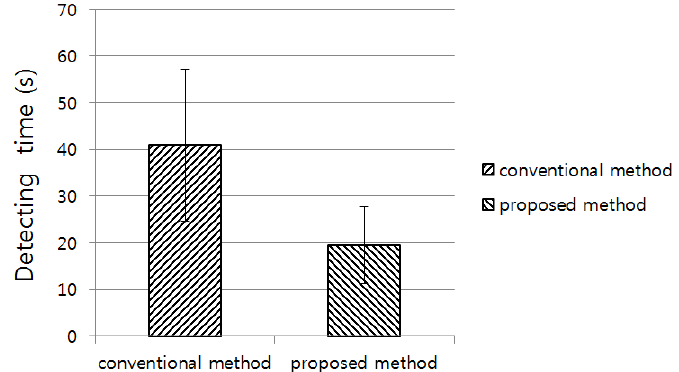
Figure 13. Comparison of detection time between the conventional and proposed methods.